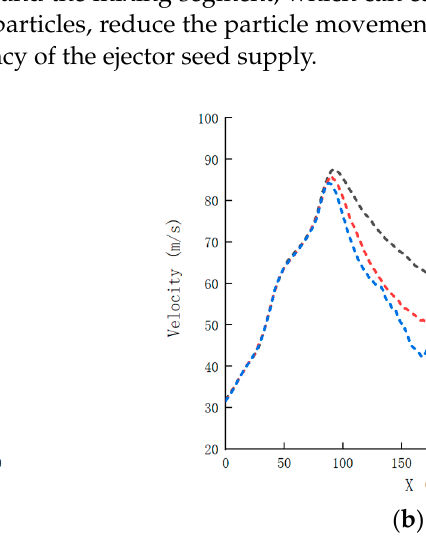
Figure 13. Characteristics of flow field in jet pipe: ( a ) axial static pressure change and ( b ) variation of axial velocity.